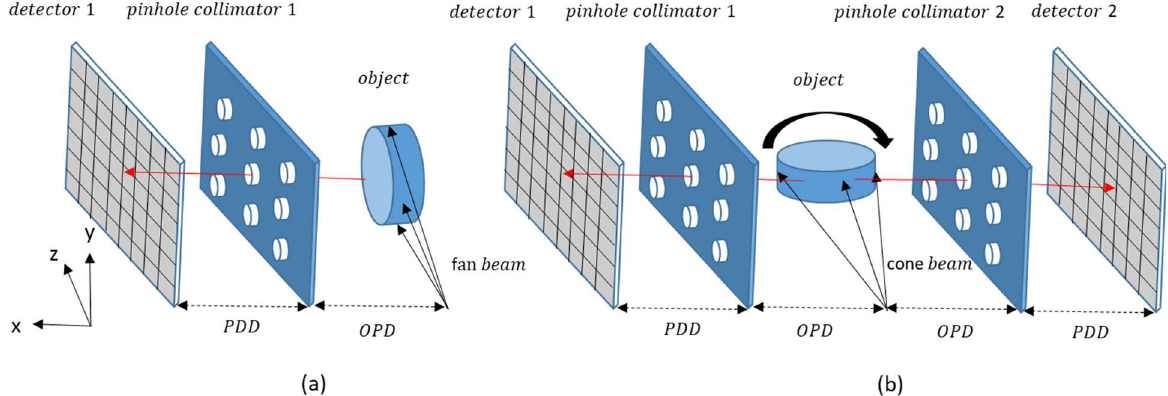
Figure 1. Schematic for the current MC models with the system components. ( a ) PMP and ( b ) MP geometries. The red arrows signify the emission of XRF photons from the phantom that strike the detectors.